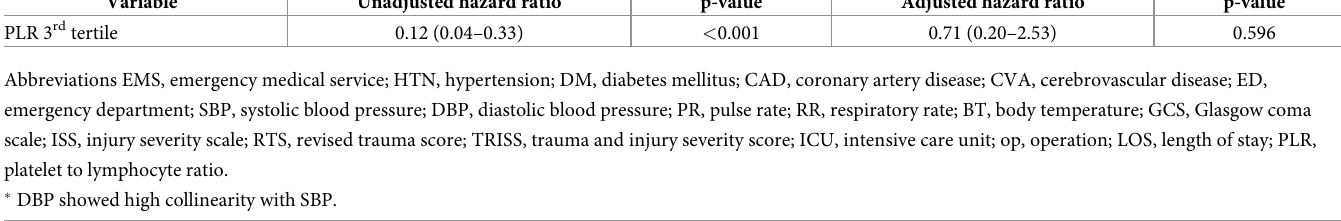
PLOS ONE | https://doi.org/10.1371/journal.pone.0233838 June 17,